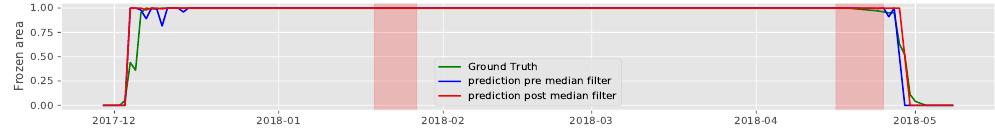
Figure 12: Frozen area time series with- and without post-processing: results of Cam0 when the network is trained using the data from Cam1. Red bars indicate periods of data gaps, where no images are stored due to technical failures. estimated ice-on/off dates are shown in Table 4. We determ- ined the ice-on/off dates for lake St. Moritz from Cam0, which covers a larger portion of the lake. For lake Sihl, multiple ice- on and off dates are found, as that lake is in a warmer (lower) region of Switzerland and froze/thawed four times within the same winter. See Table 4. Table 5: Lake ice segmentation results (IoU) on crowd-sourced dataset.